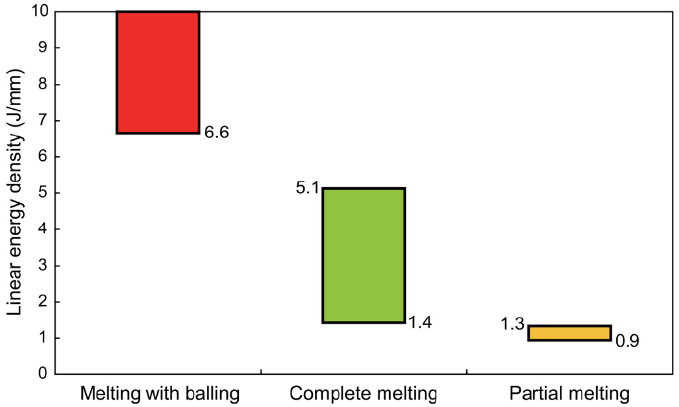
Figure 4. Energy density ranges under various laser powers and scan rates (see Figure 3).